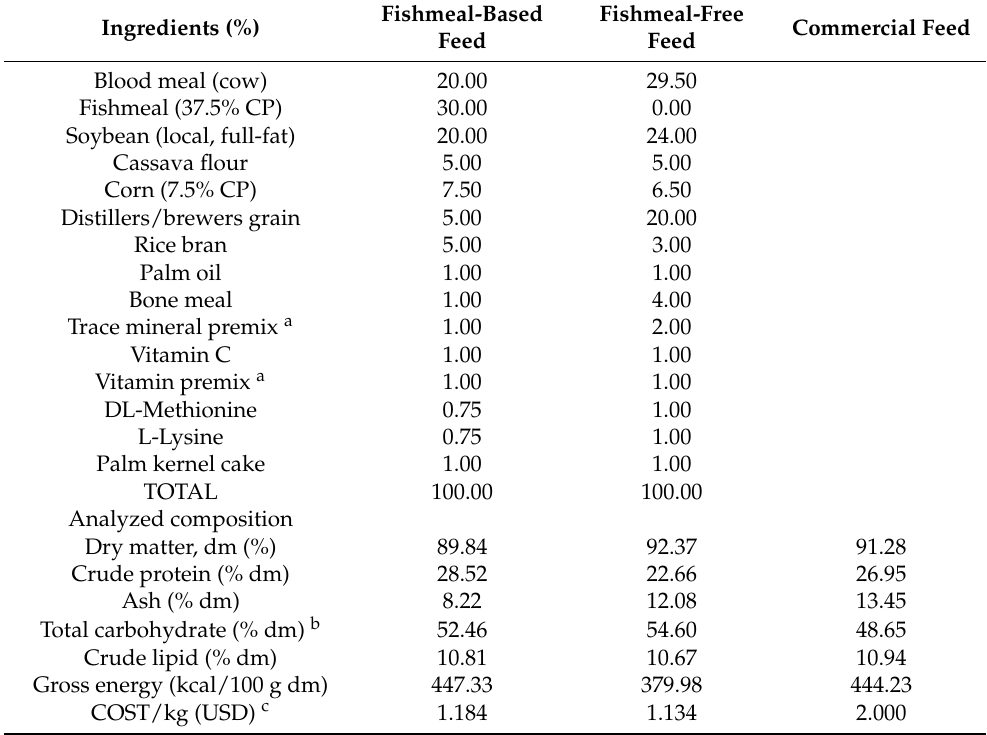
Table 1. Experiment 1 in Bukavu, eastern highlands DR Congo—composition of the commercial feed and the fishmeal-based and fishmeal-free feeds formulated using local ingredients fed Nile tilapia ( Oreochromis niloticus ) fry of the “Nyakabera” and “Lake Kivu” strains in Bukavu, DR Congo. Fishmeal-Based Ingredients (%) Feed